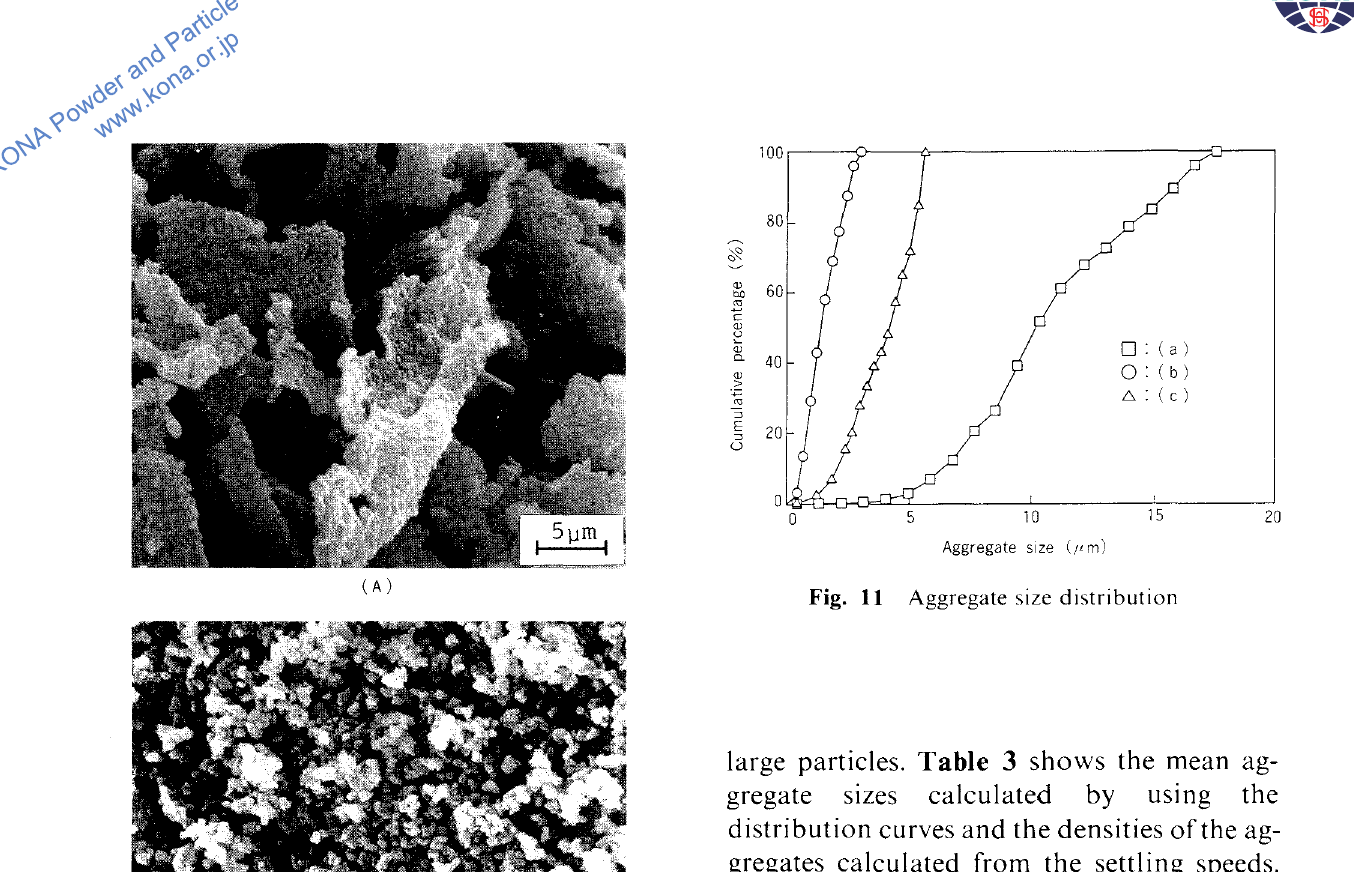
Fig. 11 Aggregate size distribution